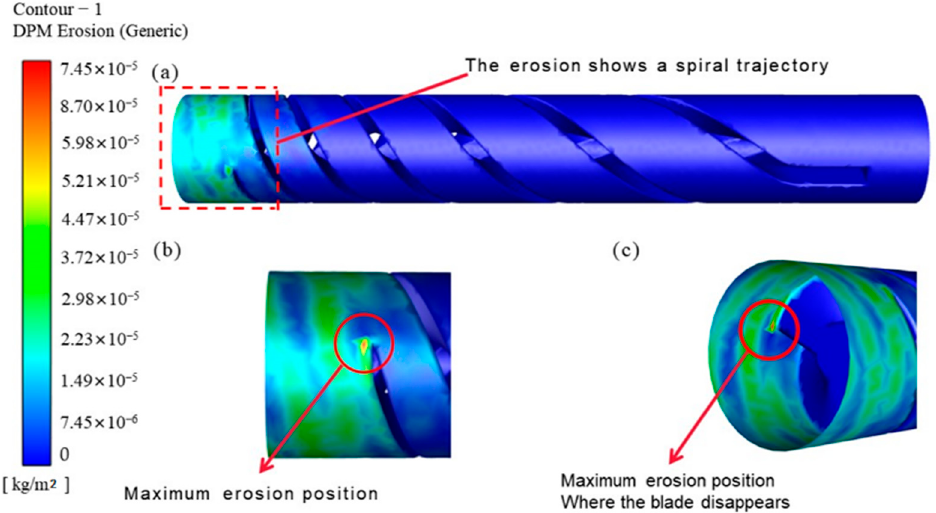
Figure 8. Pipe wall of axial downhole solid–liquid separator. ( a ) Overall erosion cloud diagram; ( b , c ) local erosion cloud diagram.